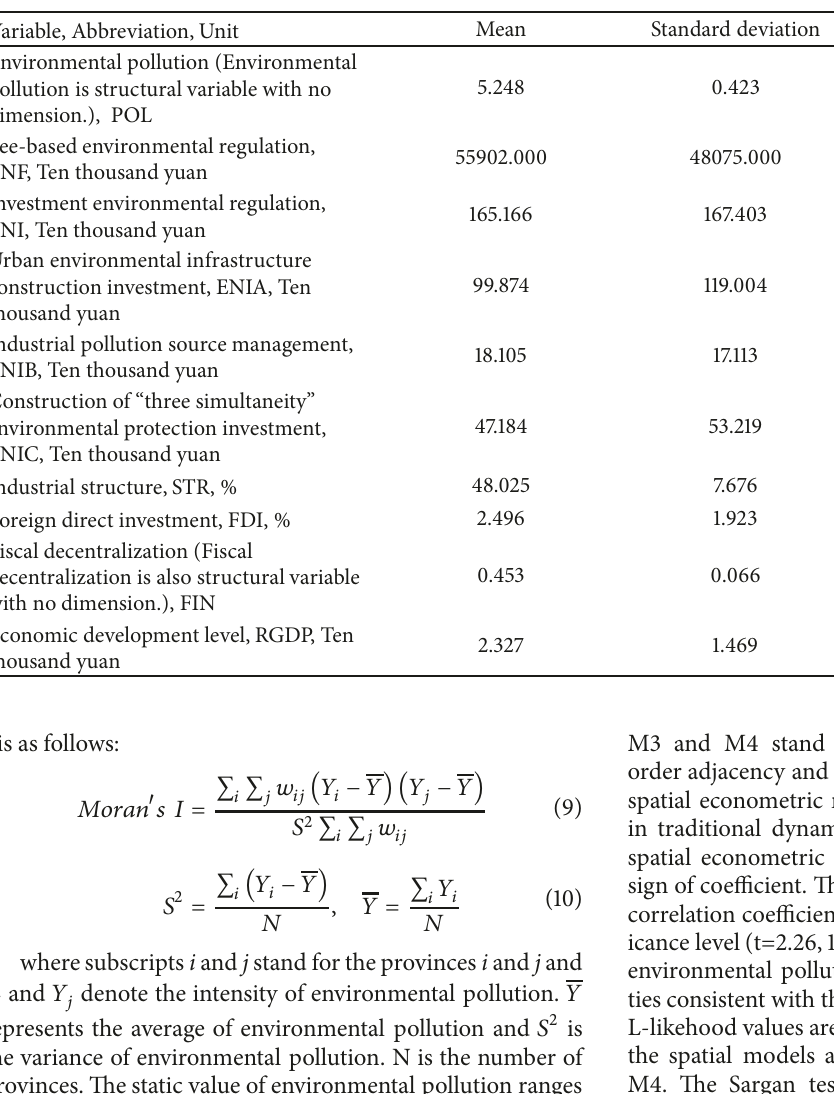
Table 1: Descriptive statistics for 390